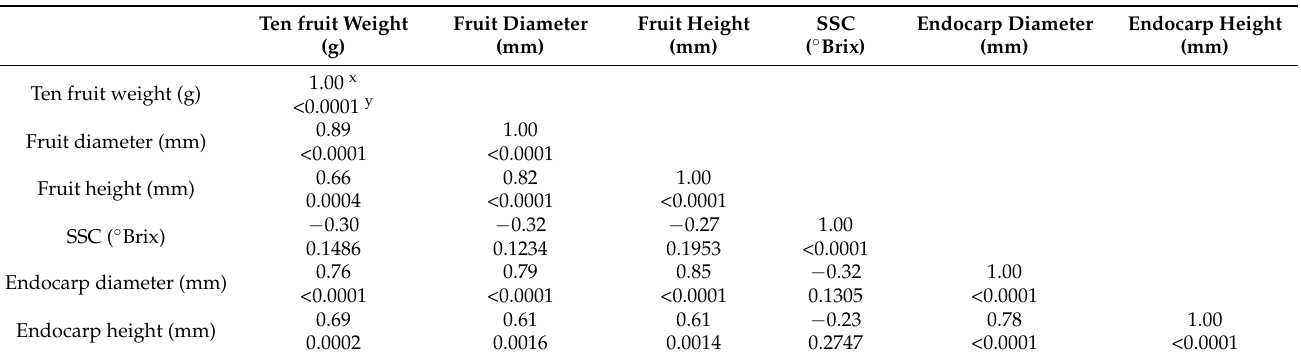
Table 6. Multivariate analysis of fruit and endocarp characteristics of Prunus serotina subsp. capuli genotypes, collected in the Andes region of Ecuador in 2019.